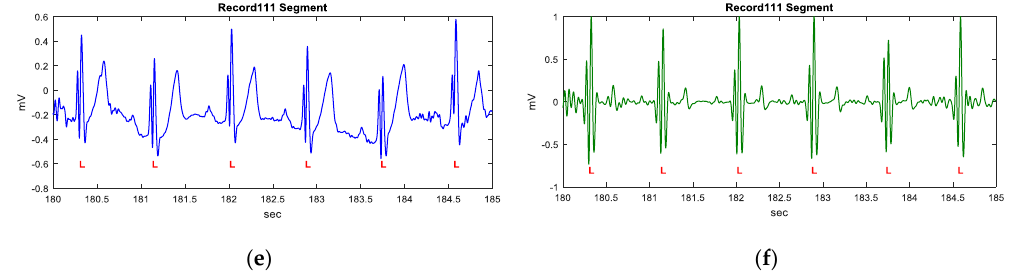
Figure 6. Signal enhancement using the proposed transformation. ( a ) Filtered ECG signal of the Record 114 segment; ( b ) Transformed signal of the Record 114 segment by the proposed transformation; ( c ) Filtered ECG signal of the Record 108 segment; ( d ) Transformed signal of the Record 108 segment by the proposed transformation; ( e ) Filtered ECG signal of the Record 111 segment; ( f ) Transformed signal of the Record 111 segment by the proposed transformation.